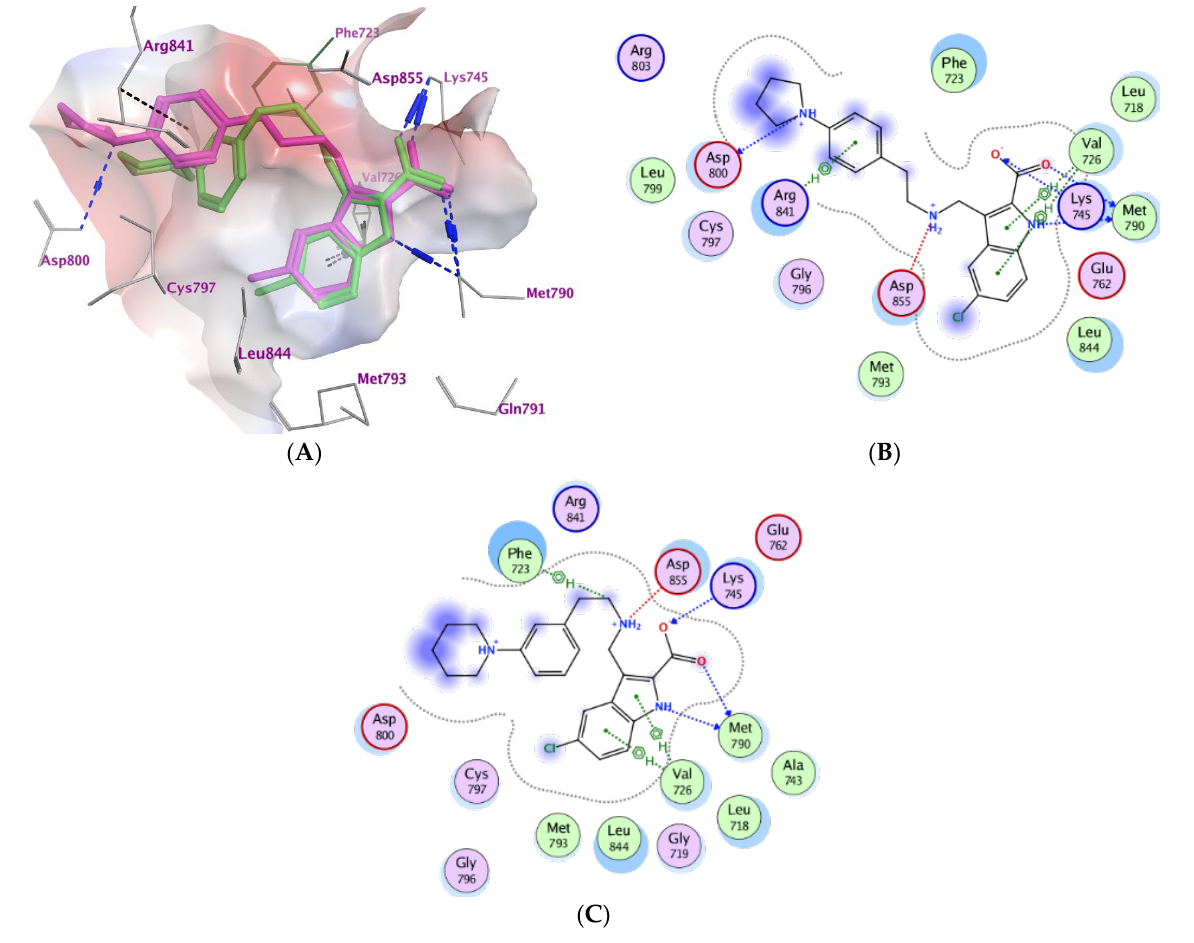
Figure 3. Docking representation models for compounds 3b and 3e ; ( A ): 3D-docked models of compound 3b (purple) aligned with 3e (green) within the active site of EGFR T790M showing the interaction surface of the protein (electrostatics; green: hydrophobic, blue: positive, and red: negative); ( B ): 2D-docked model of compound 3b within the active site of EGFR T790M ; ( C ): 2D-docked model of compound 3e within the active site of EGFR T790M .